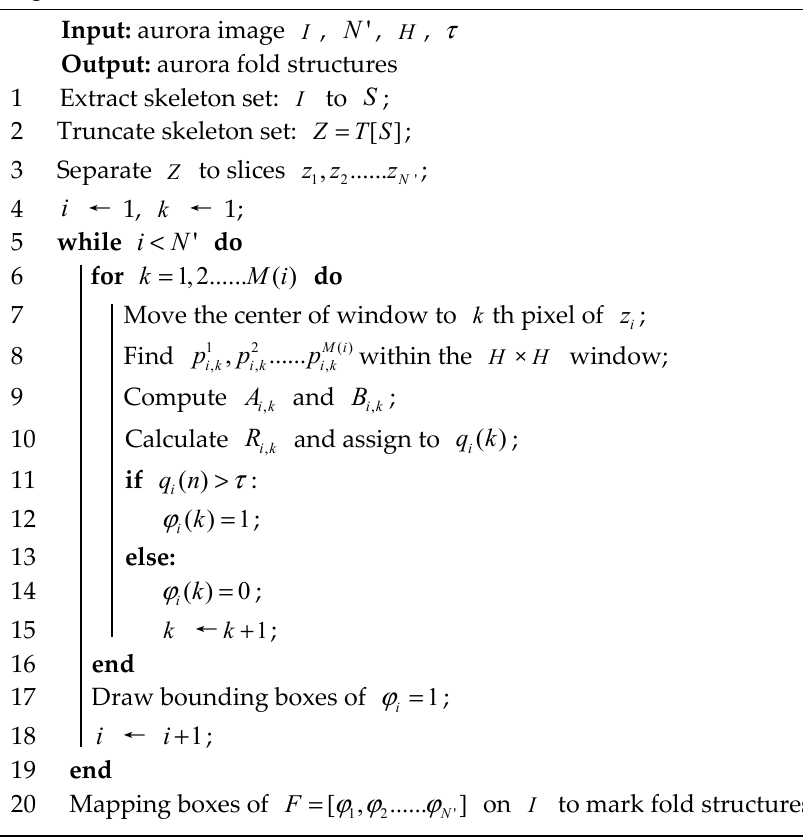
Algorithm 1: Aurora fold structure automatic identification.